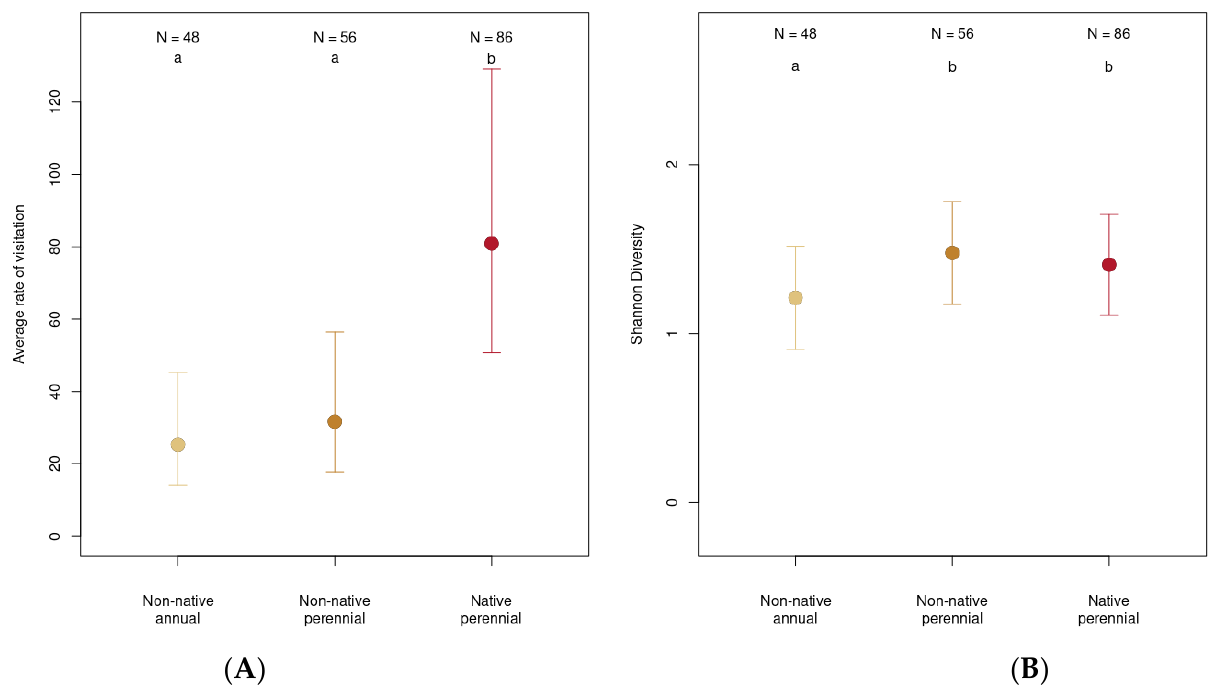
Figure 5. ( A ) Native perennials attracted more insect pollinators, as measured by average abundance (95% confidence interval) per year, than non-native perennials or non-native annuals. ( B ) Non-native perennials attracted more diverse groups of insect pollinators, as measured by a diversity score (95% confidence interval), than either native perennials or non-native annuals. Both graphs show statistically significant results, and letters denote post hoc results between categories.